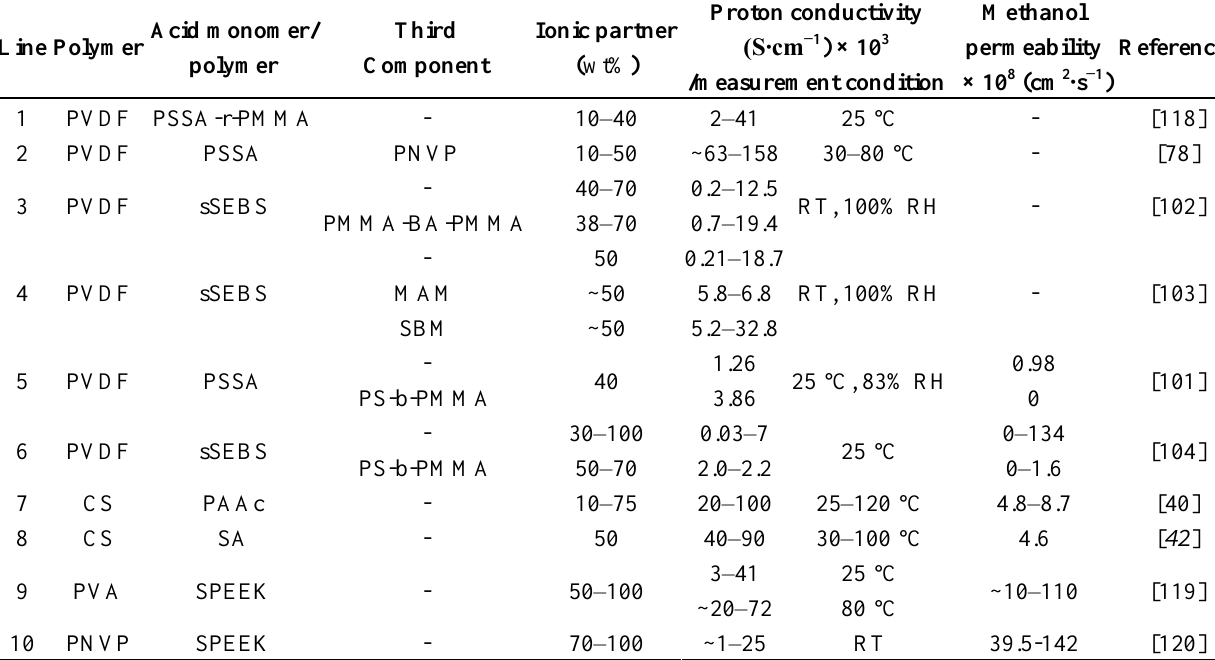
Table 3. Characteristics of various water soluble polymers combined in blended polyelectrolyte complex